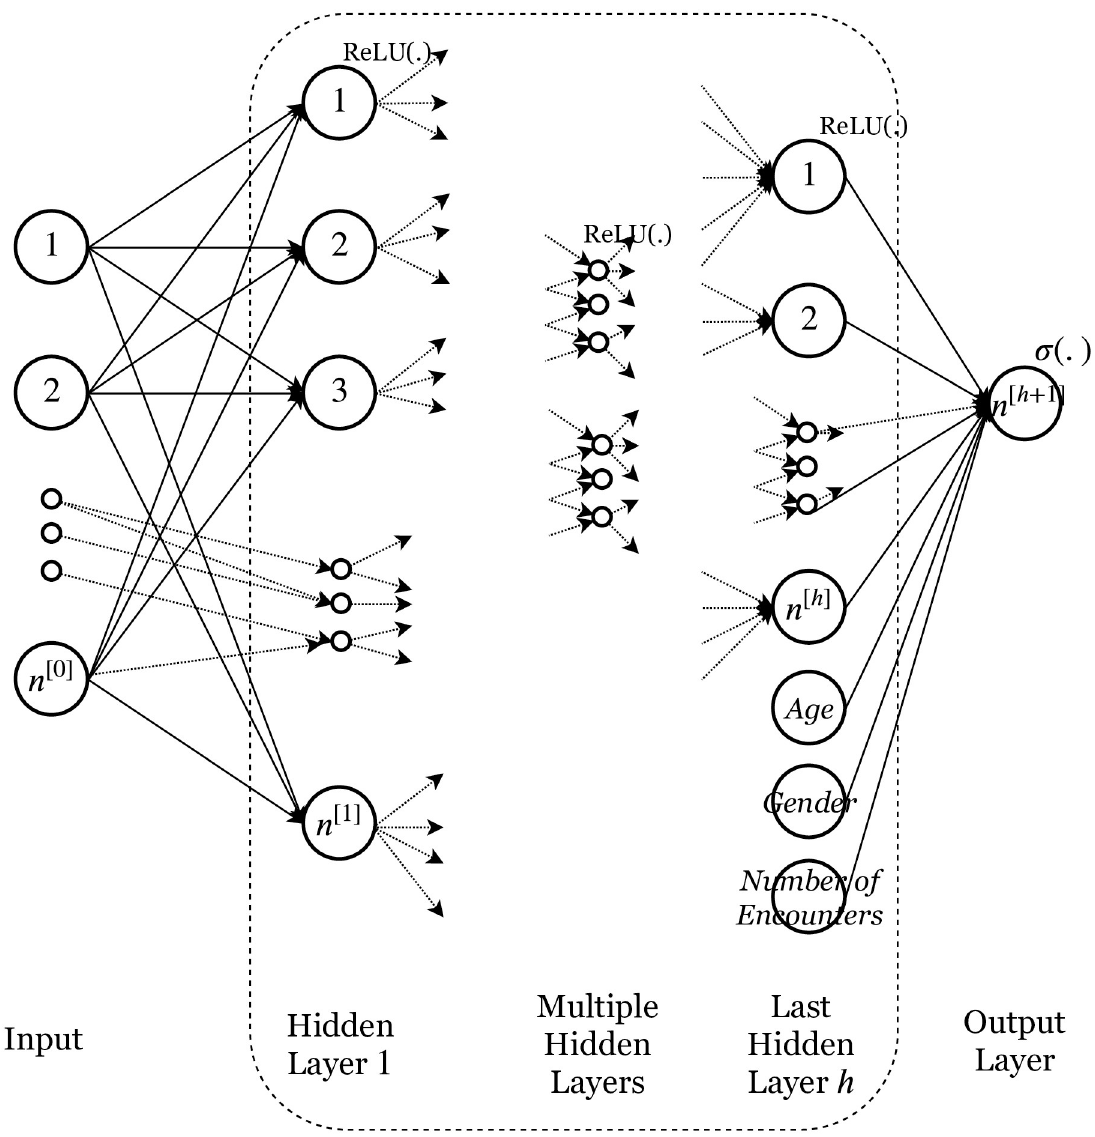
Fig 1. Feed forward network